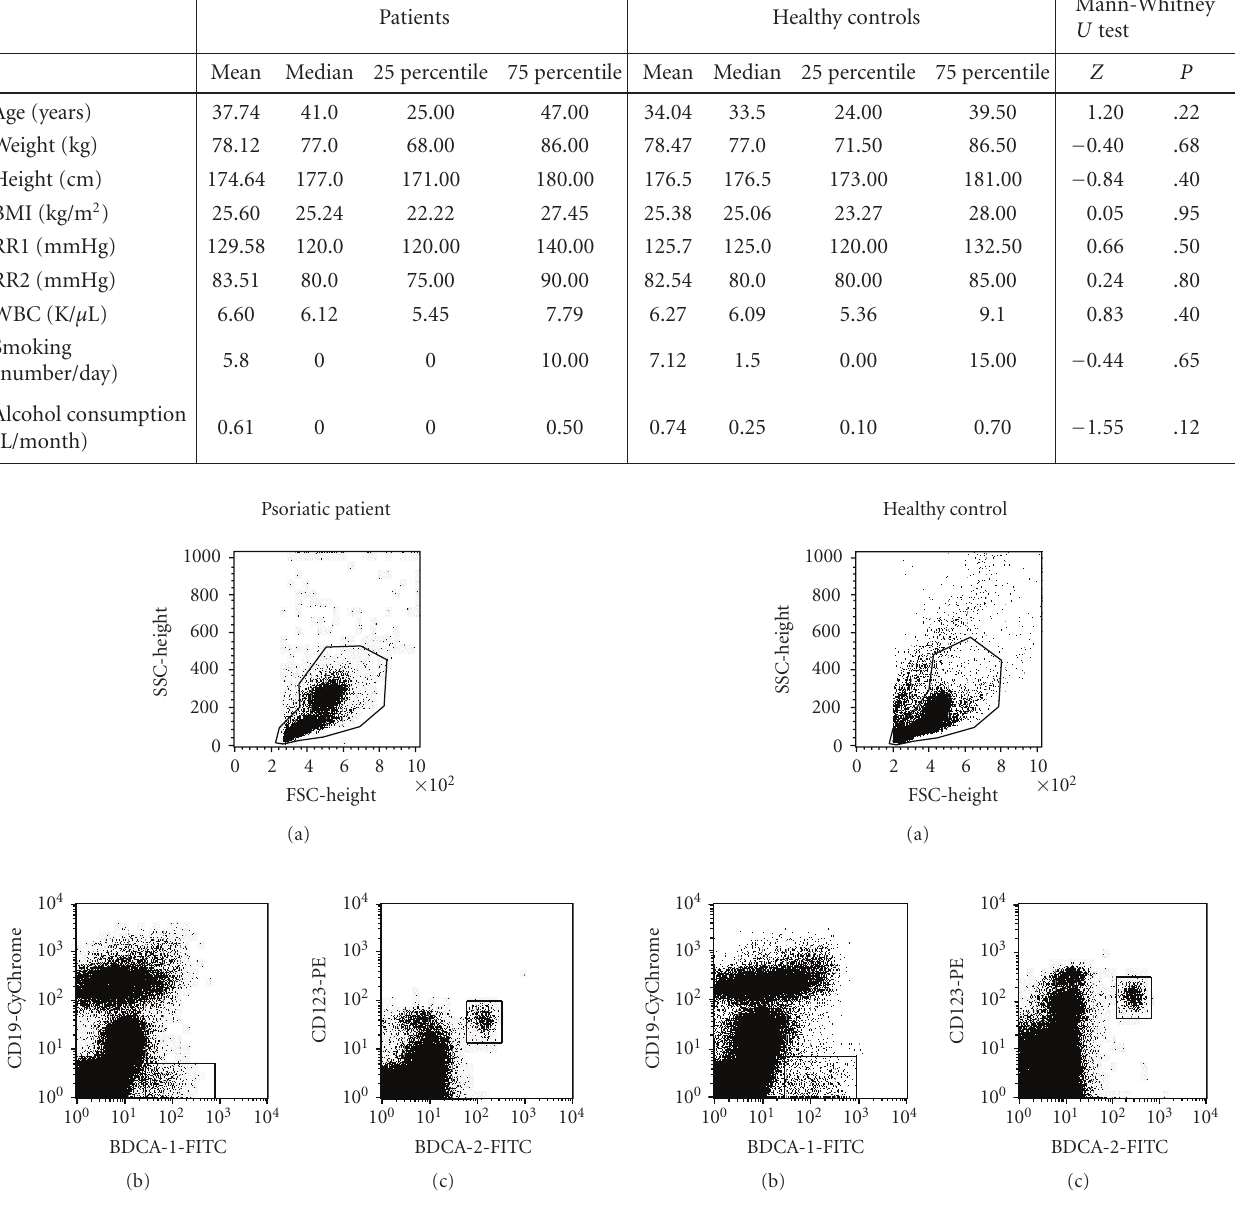
Figure 1: (a) Myeloid and plasmacytoid DCs were quantified as the percentages of peripheral blood mononuclear cells, (b) mDCs were defined as BDCA-1 positive and simultaneously CD19 negative cells, (c) pDCs as double BDCA-2 and CD123 positive cells. Correlations between IL-18 and DCs in patients with psoriasis and healthy